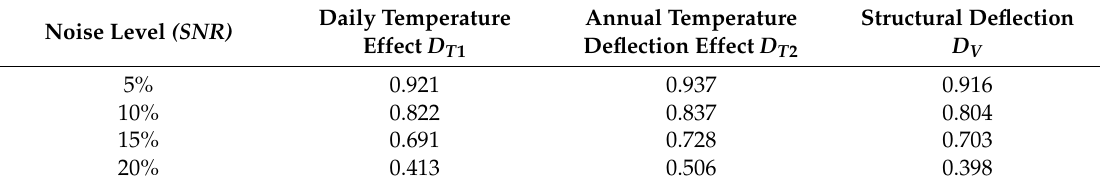
Table 2. Correlation coefficients ( ψ ) between the source signals and estimated components under different noise levels.